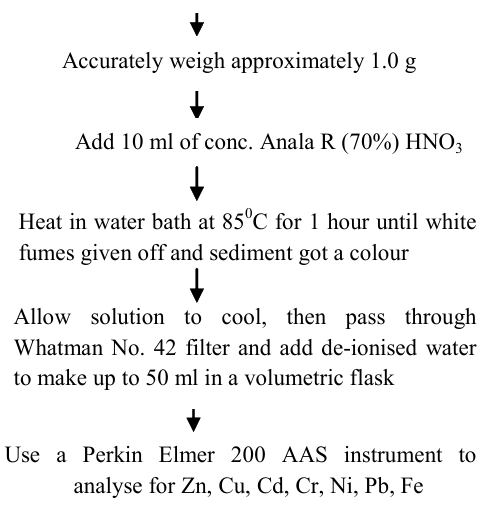
Figure 1. Analytical protocol for RDS metal